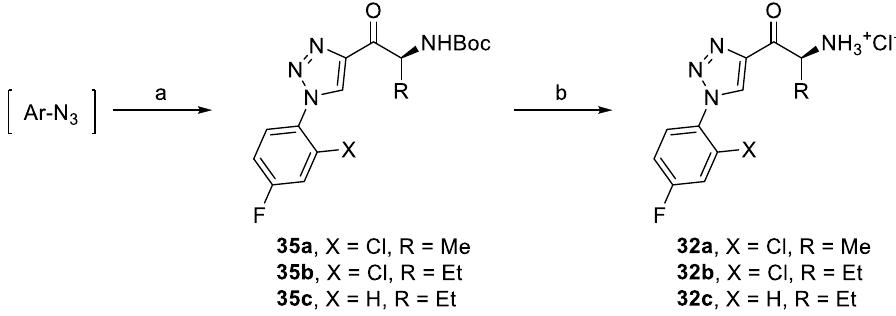
Figure 11. Synthesis of triazole derivatives based on SAR. Reagents and conditions: (a) 15 or 18e , CuTC, toluene, r.t., 79 – 83%, and (b) AcCl, MeOH, 0 °C – r.t., 65 – 90%.